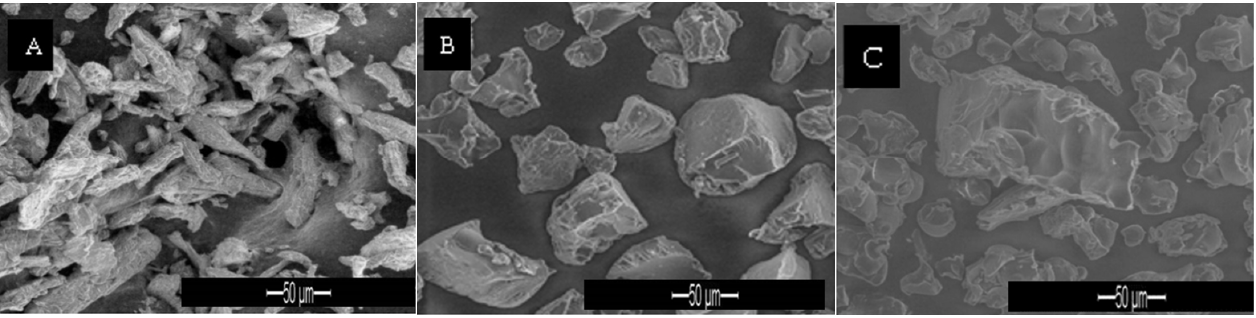
Figure 4. SEM images of ( A ) Avicel ® PH 101; ( B ) Spress ® B820; ( C ) pregelatinised sago starch. Table 2. Mean particle diameter, moisture content, densities, angle of repose and AUC T vs P of each excipient bulk powder. Excipients Avicel PH 101 Spress ® B820